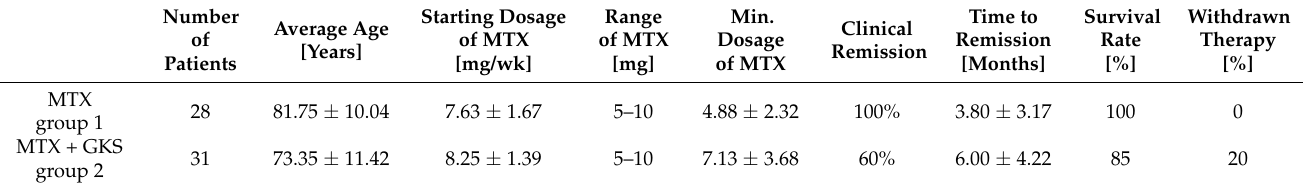
Table 1. Characteristic of the